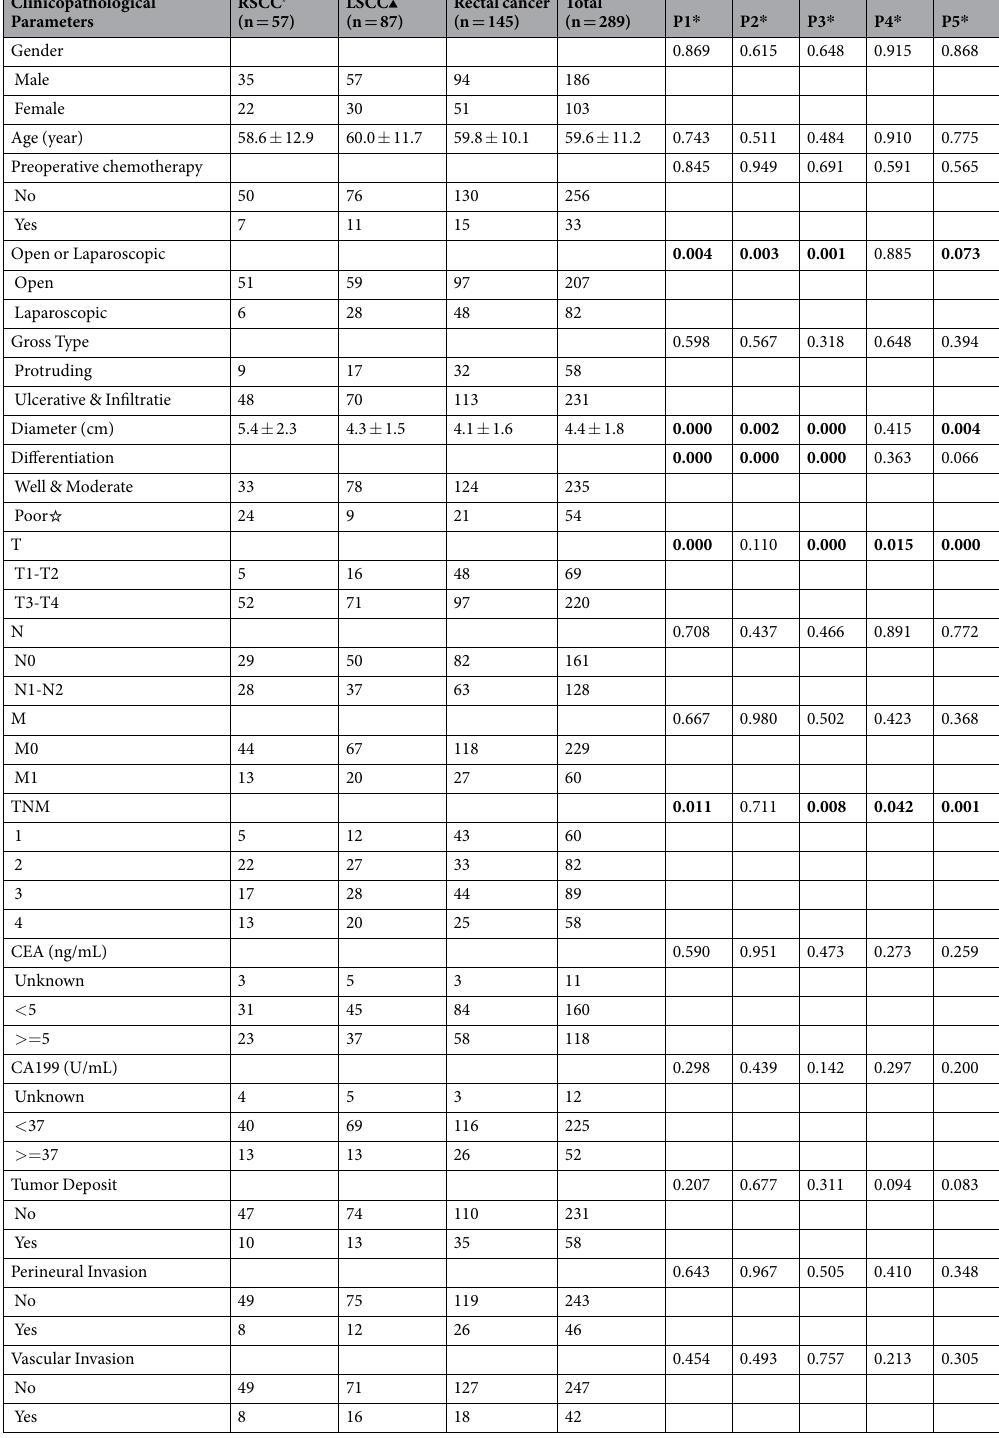
Table 2. Relationship between Tumor Position and Clinicopathological Parameters in 289 Colorectal Cancer Patients. # RSCC: Right-sided colon cancer; ▴ LSCC: Left-sided colon cancer; * P1: comparison of three